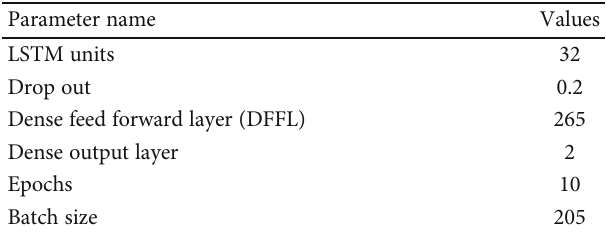
Figure 3: LSTM model for cyberattack detection. Table 1: Parameter values of LSTM model used in the proposed